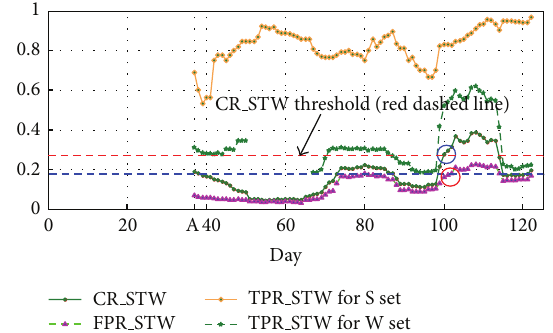
Figure 6: Performance for the initial reference model image set MOA over